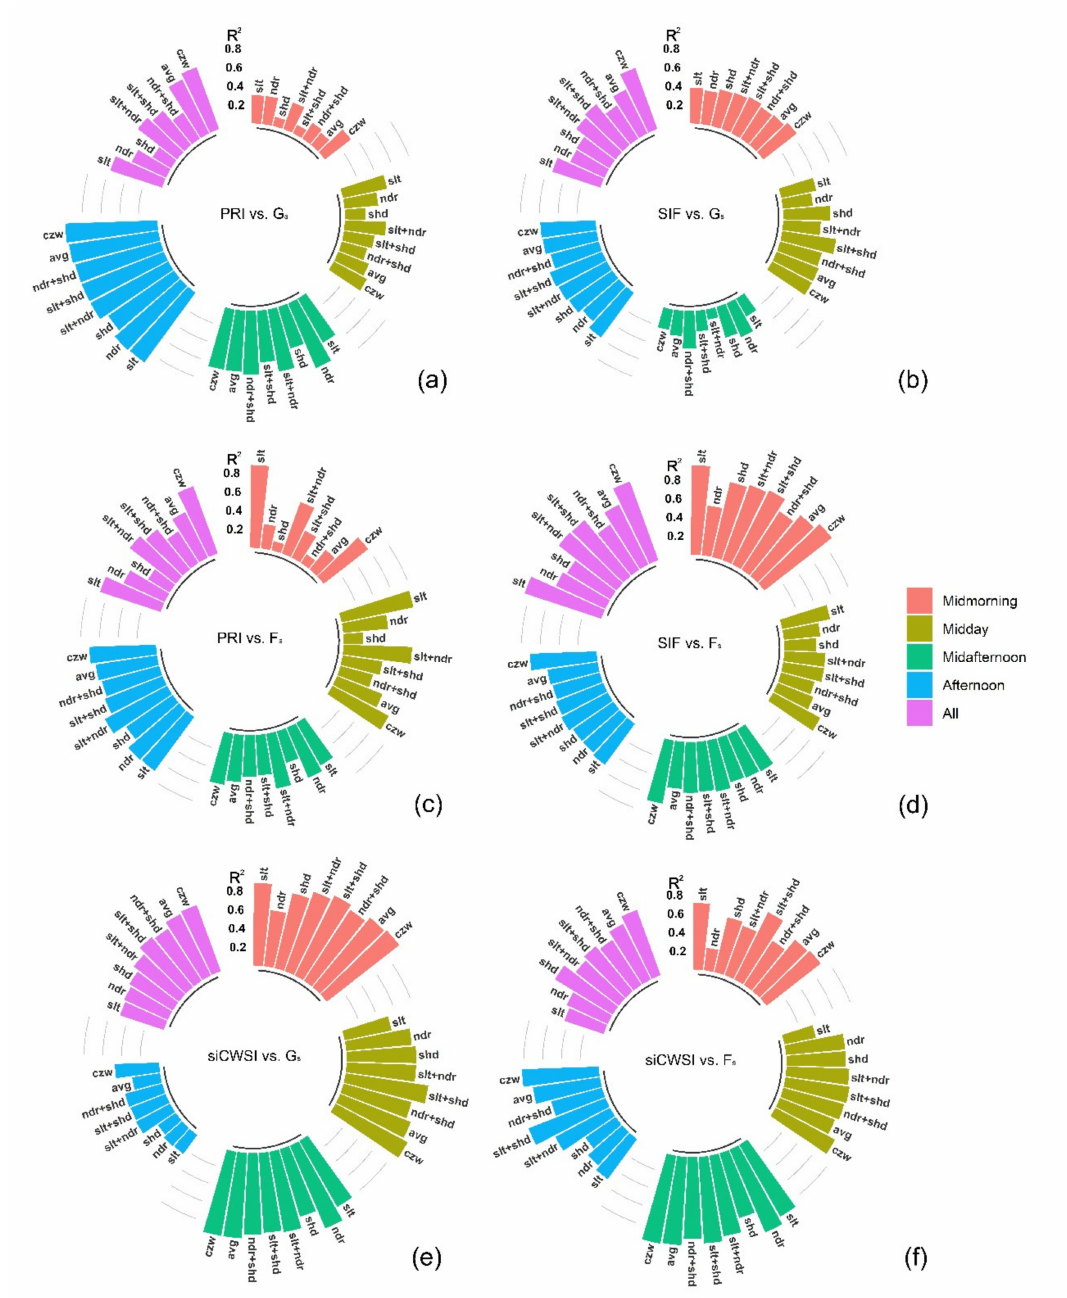
Figure 12. Circular bar plots show the relationships (R 2 ) established between the image retrievals (PRI, SIF, and siCWSI) and physiological indicators (G s and F s ) for the four flights conducted on 1 August 2018 and all flights combined on this date. ( a , b , e ) show the R 2 values between PRI, SIF, and siCWSI from di ff erent canopy zones and stomatal conductance (G s ), and ( c , d , f ) show the R 2 values between PRI, SIF, and siCWSI from di ff erent canopy zones and steady-state fluorescence (F s ). slt is for sunlit canopy zone, ndr is for nadir canopy zone, shd is for shaded canopy zone, avg is for average value of entire canopy zone, and CZW is for canopy zone-weighting